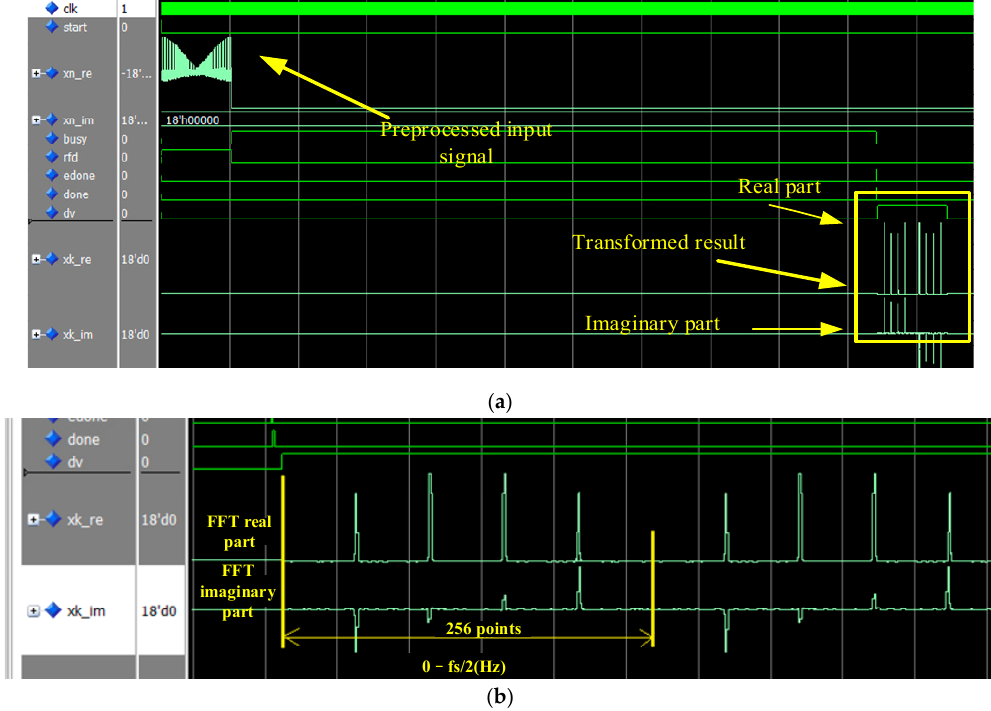
Figure 23. Waveform simulation diagram of the spectral analysis module: ( a ) all-phase FFT module test overall diagram and ( b ) all-phase FFT module test partial magnified diagram.